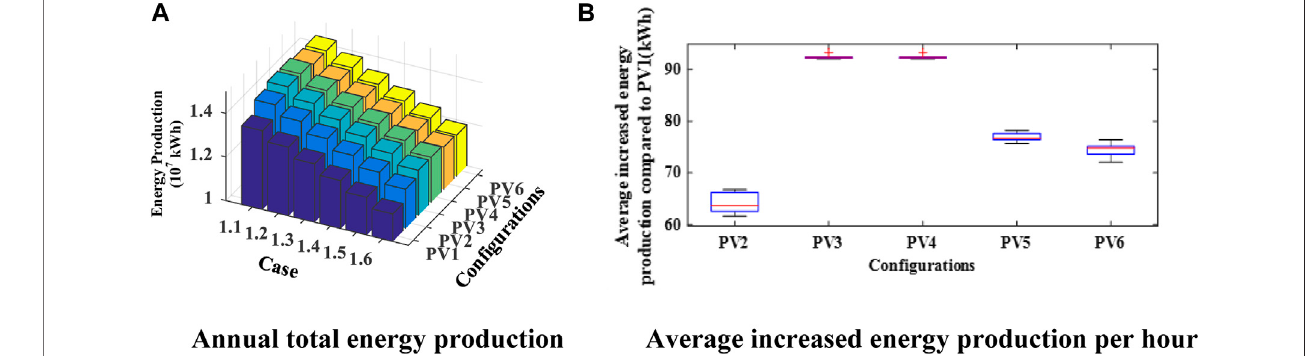
FIGURE 10 | Comparison of six cases for the PV panel aging. (A) Annual total energy production. (B) Average increased energy production per hour.